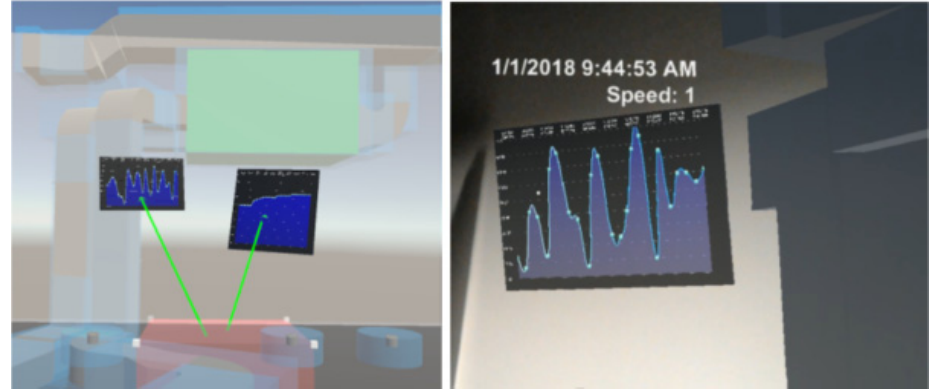
Figure 7. Example from Prouzeau et al.: On the left image, we can see the authoring of a specific zone (in red) for a situated visualisation. On the right image, the situated visualisation appears to the AR use when they enter the corresponding location [25].